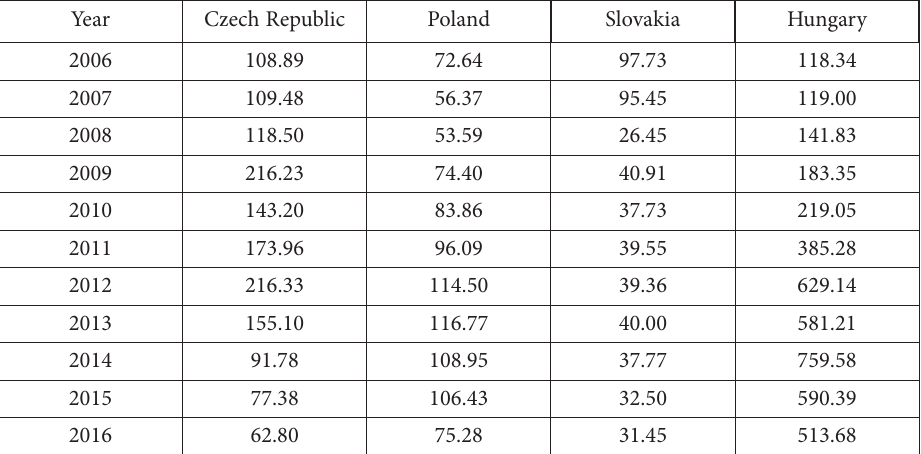
Table 3. One-base indices of the number of bankruptcies in the Visegrad Group countries (source: Own work) Year